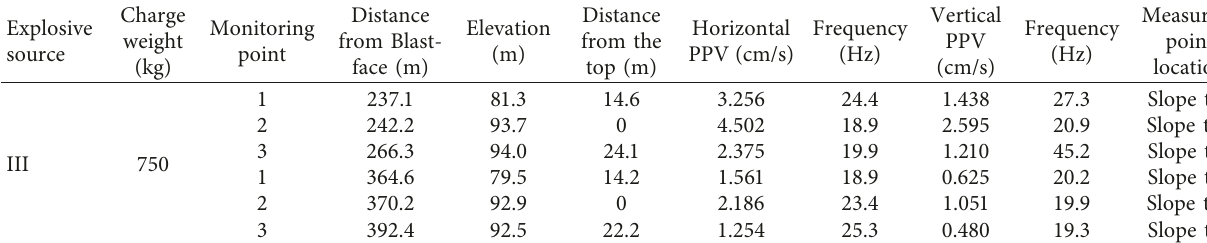
Table 8: Six more sets of vibration data.